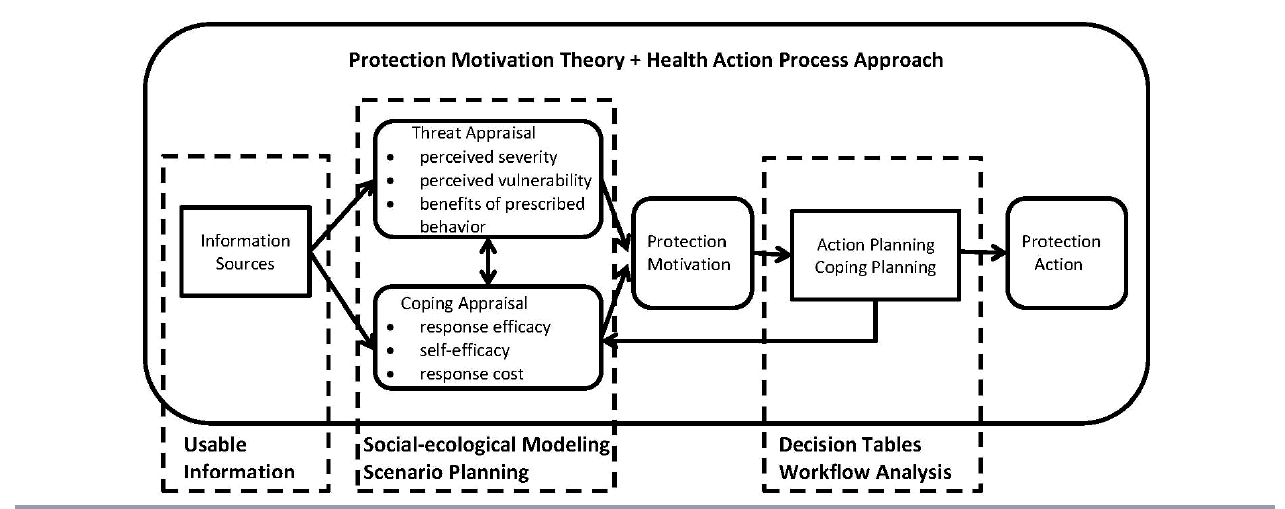
Fig. 1 . Collaborative protection motivation theory + health action process approach (C-PMT+HAPA) framework for increasing protection motivation and